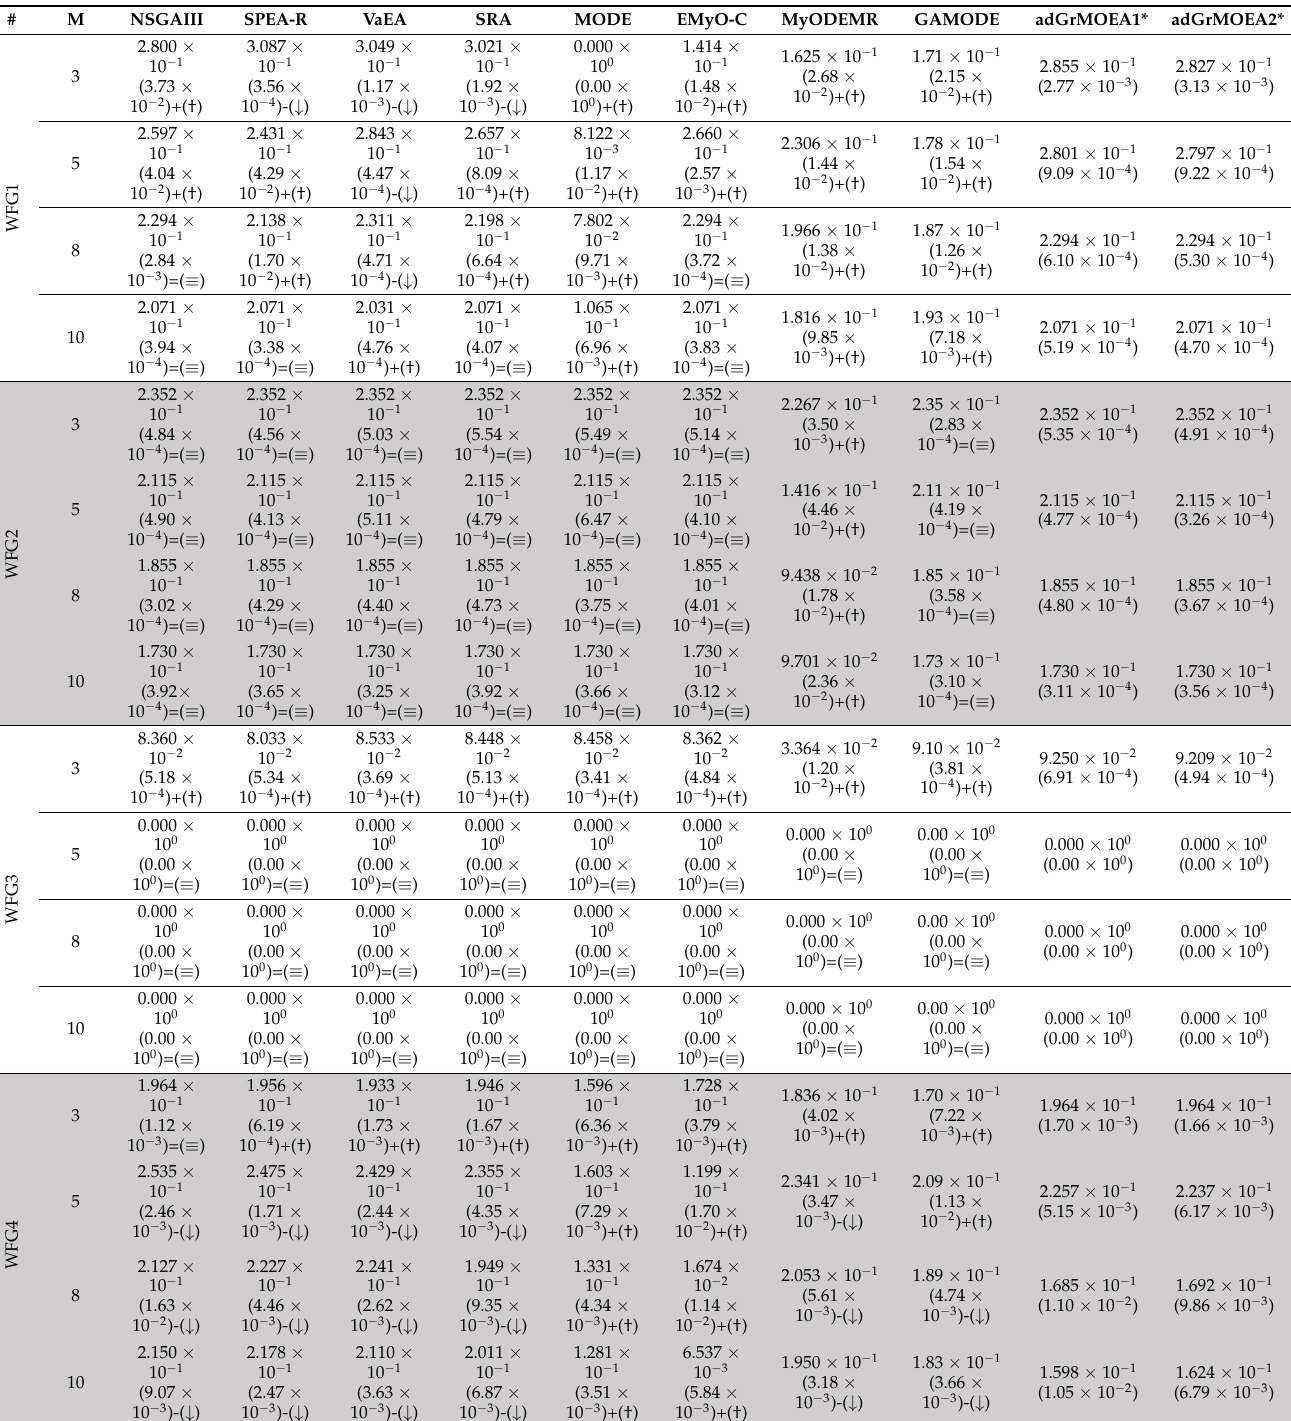
Table A4. Mean and standard deviation values of HV results of proposed method with state of art algorithms on WFG